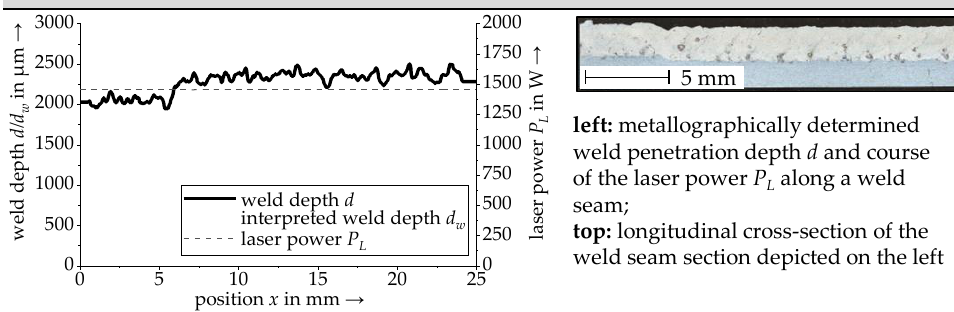
Figure 10. Comparison of the weld depth profiles for a targeted depth of 2.0 mm with a 300 µm deep notch for the aluminum alloy AA2219 with active weld depth control (top), for the aluminum alloy EN AW-6082 with active weld depth control and for the aluminum alloy EN AW-6082 without weld depth control.